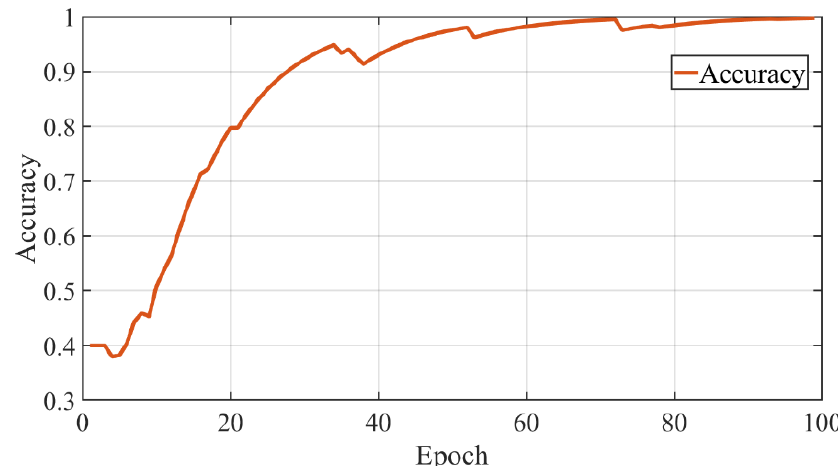
Figure 13. The accuracy of the intended part recognition model.